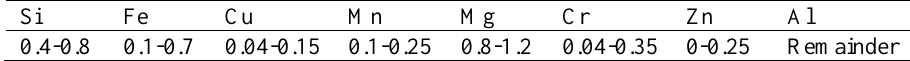
Table 1. Chemical composition of